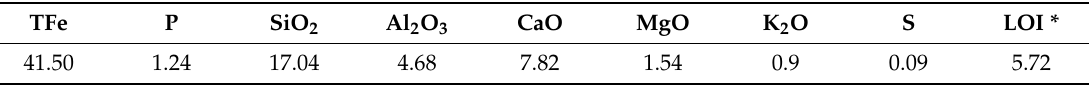
Table 1. Chemical composition of oolitic hematite ore/wt. %.